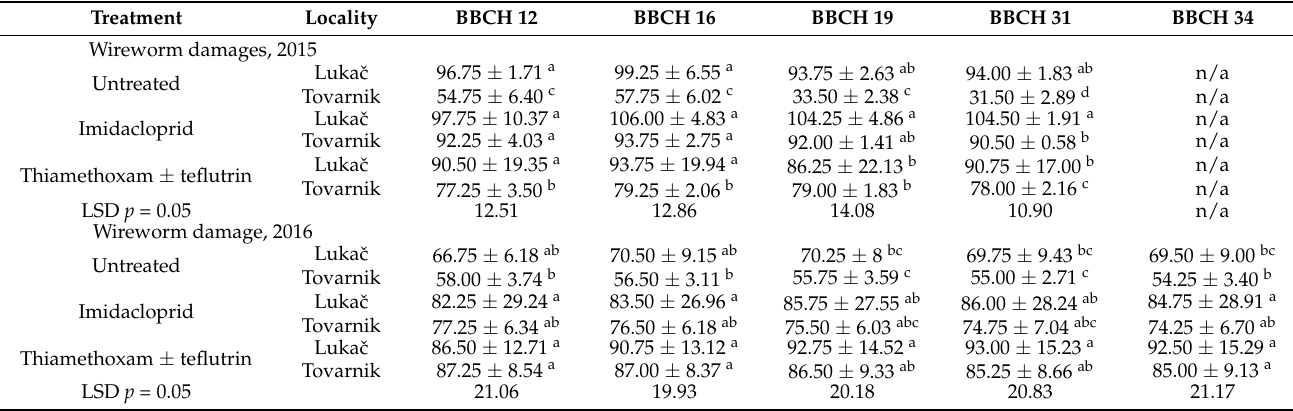
Table 1. Crop stand (number of plants/10 m 2 ) established on different treatments in different plant developmental stages (BBCH).